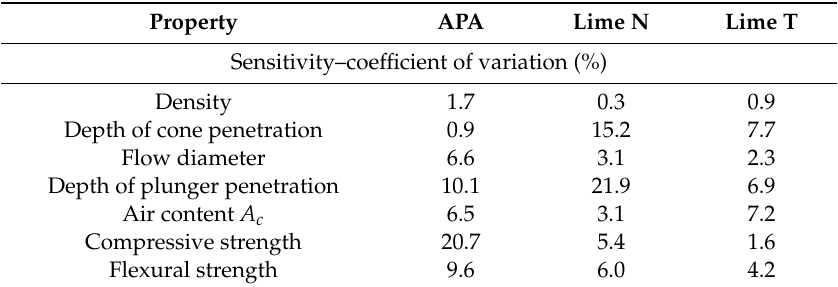
Table 20. The sensitivity of masonry mortar properties to changes in mixing